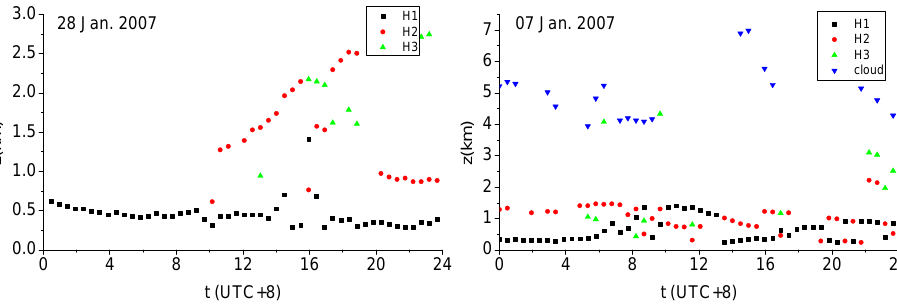
Fig. 2. Temporal evolution of aerosol layer height on two days in January 2007. Each dot represents the average for five minutes measure- ments. Measurements were taken every 30min. Fig. 2: Temporal evolution of aerosol layer height on two days in Jan. 2007. Each dot 426 represents the average for five minutes measurements. Measurements were taken 427